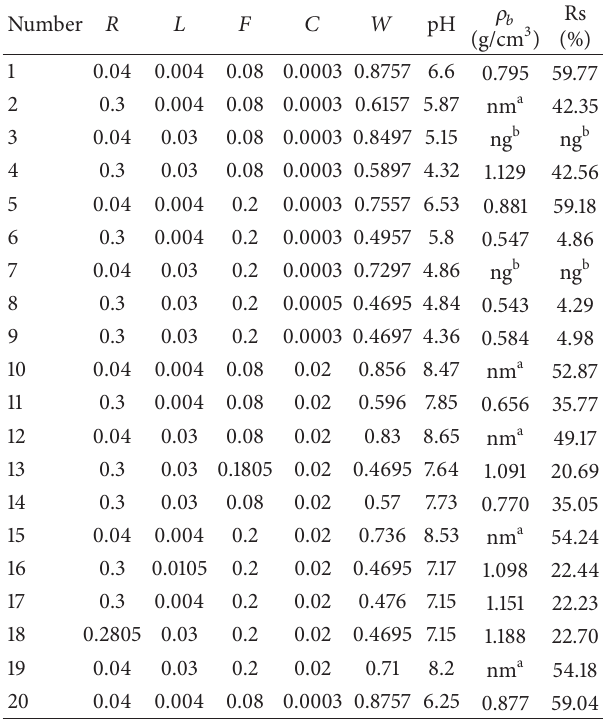
Table2:Matrixandresultsforextremeverticesmixingdesign(mass